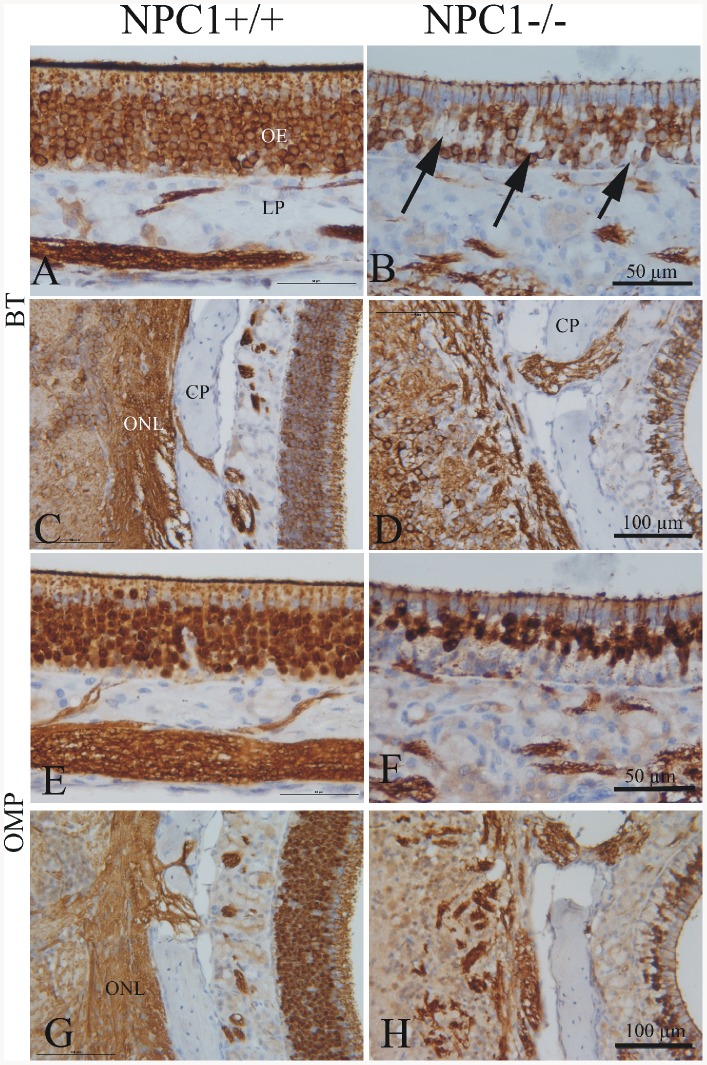
Immunohistochemistry of olfactory epithelium (OE) and olfactory bulb (OB) in adult NPC1+/+ and NPC1−/− mice (67–70 d).Beta-tubulin (BT, A–D); Olfactory marker protein (OMP, E–H). (A) Regular columnar epithelium (OE) and olfactory nerve fibers in the lamina propria (LP). In contrast, the number of BT-positive cells is markedly decreased (B). There are large gap-like spaces in the suprabasal area of the epithelium (arrows). (C) Olfactory mucosa (right side) and nerve fiber layer of the OB show a normal morphology. Bundles of olfactory nerve fibers travel through gaps of the cribriform plate (CP) into the olfactory nerve layer (ONL) of the OB (left side). (D) ORN are more scattered and appear interrupted in the NPC1−/− animal. (E, G) OMP reactivity in NPC1+/+, detected in mature ORN, is comparable to the distribution of BT (see A and C). NPC1−/− mice (F, H) exhibit similar deficits as shown for BT in B and D. OMP antigen is also located in nuclei. Counterstained with hematoxylin.